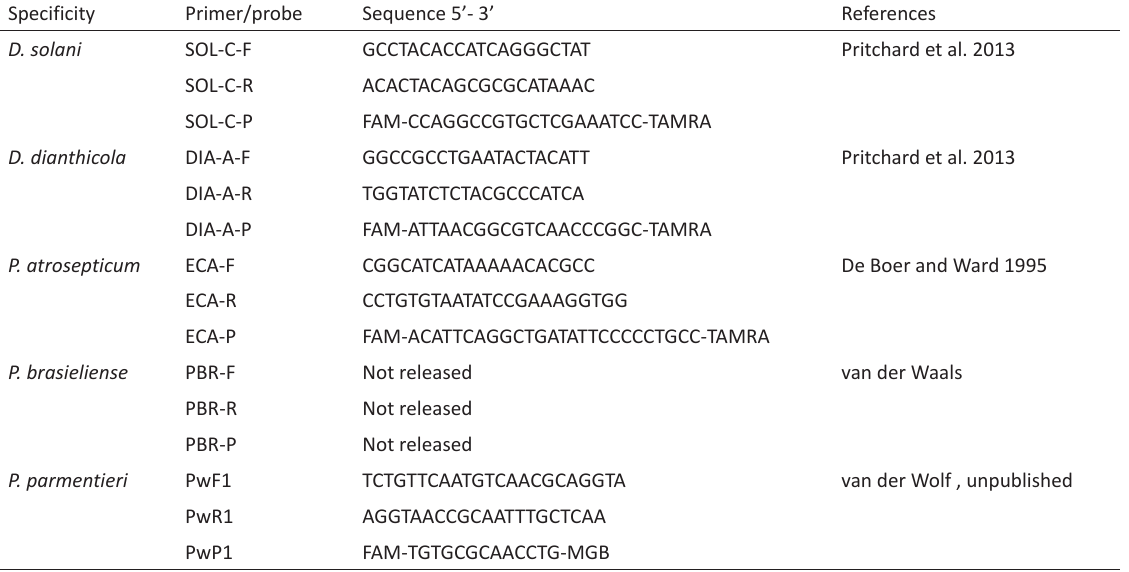
Table 2. Primers and probes used in real time quantitative PCR